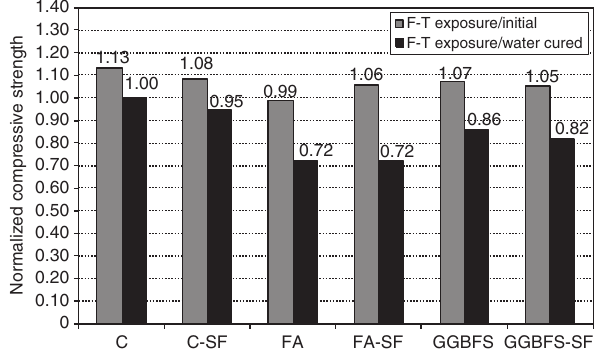
Figure 4 Normalized compressive strength after F-T exposure compared to the initial and water-cured